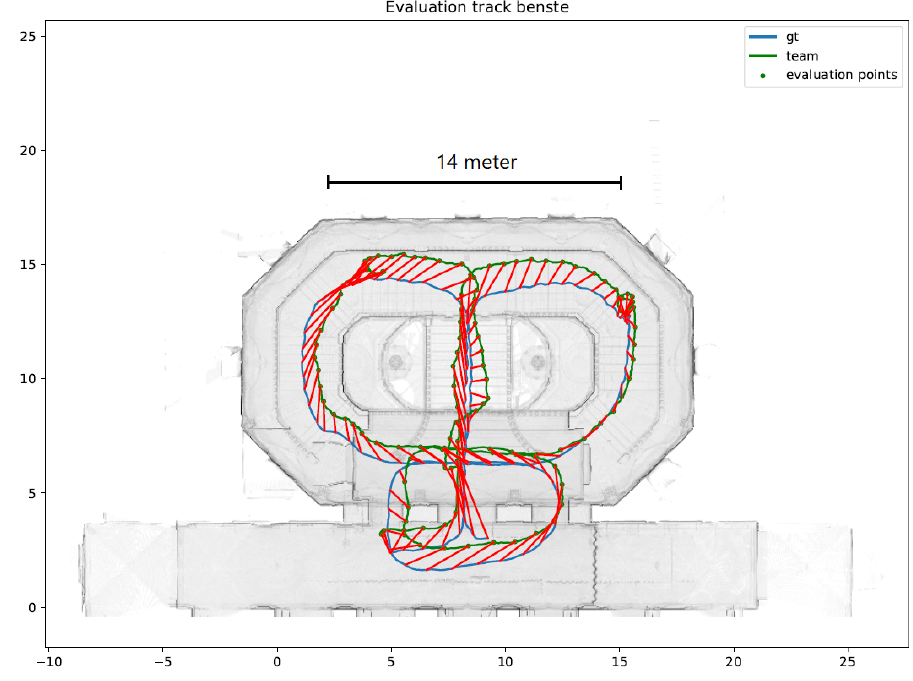
Figure 12. The STEPS path with the 2 D error with respect to a centimeter-level lidar-based ground